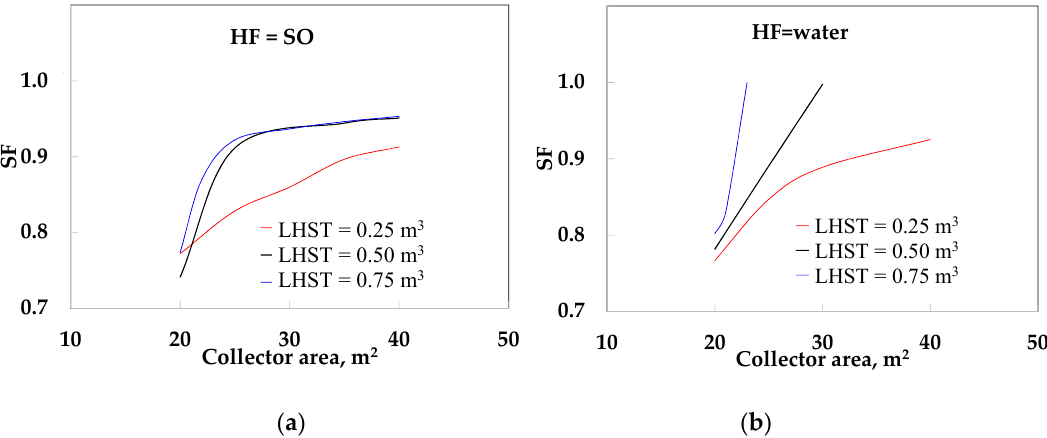
Figure 14. Solar fraction as a function of PTC collector area for LHST (configuration 2) using ( a ) SO and ( b ) water.